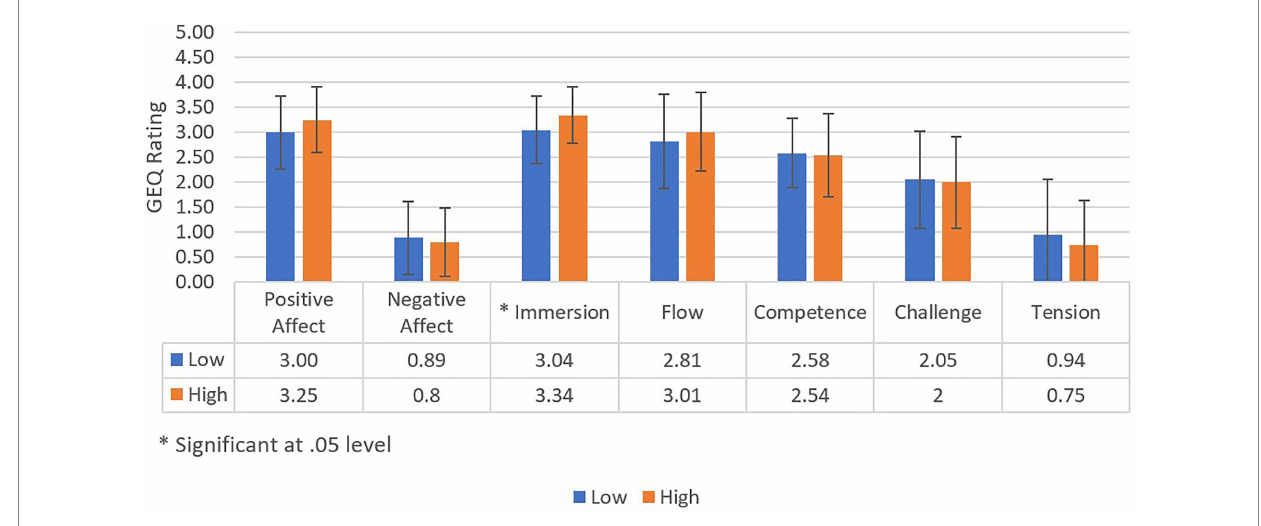
FIGURE 6 Game experience dimensions between the high- and low-performers.